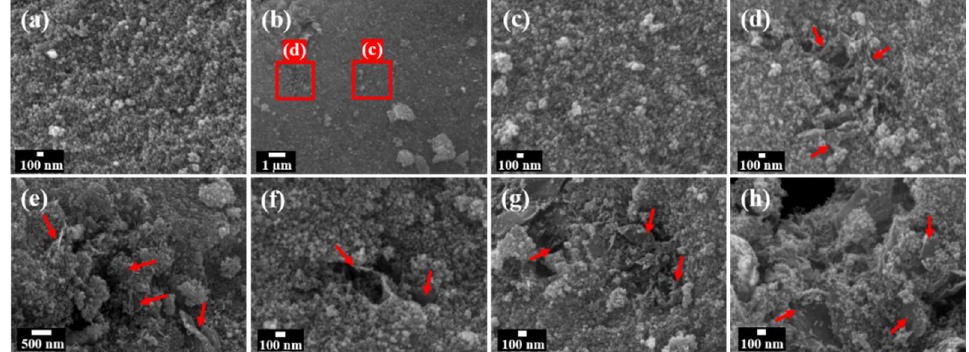
Figure 4. Field-emission scanning electron microscopy images of: ( a ) pristine SnO 2 aerogel (PTO); ( b ) SnO 2 aerogel/reduced graphene oxide (rGO) nanocomposites with an rGO loading of 0.1 wt.% (TGO1); ( c,d ) magnification of red square areas in ( b ), showing the rGO incorporation in the SnO 2 aerogel matrix; ( e–h ). The red arrows represent rGO sheets.